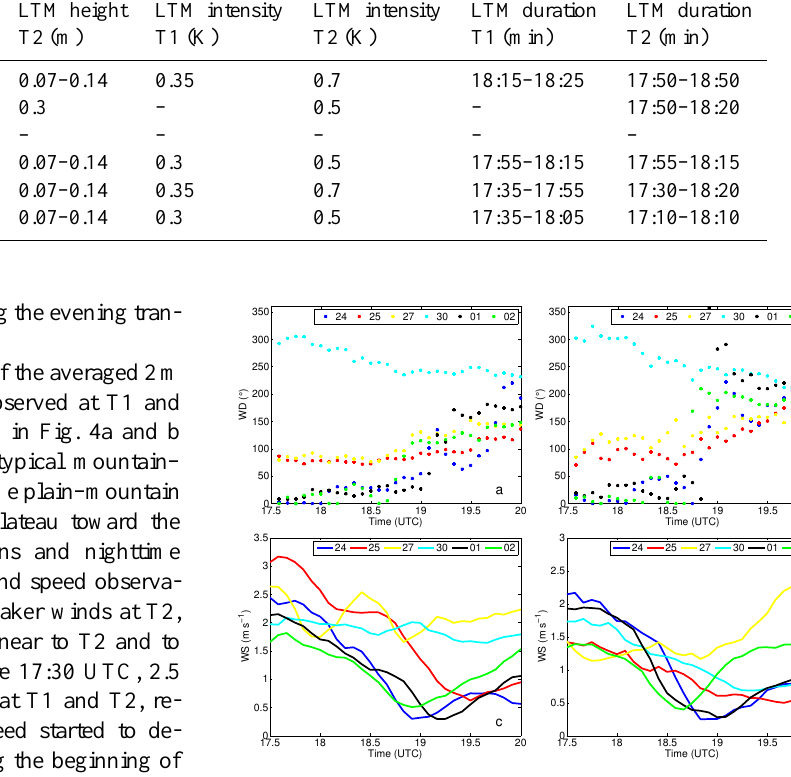
Figure 4. Temporal evolution, from 17:30 to 20:00 UTC, on all the studied days of the observed 2m wind direction (top) and speed (bottom) averaged every 5min at T1 (left) at 2.3m and T2 (right) at